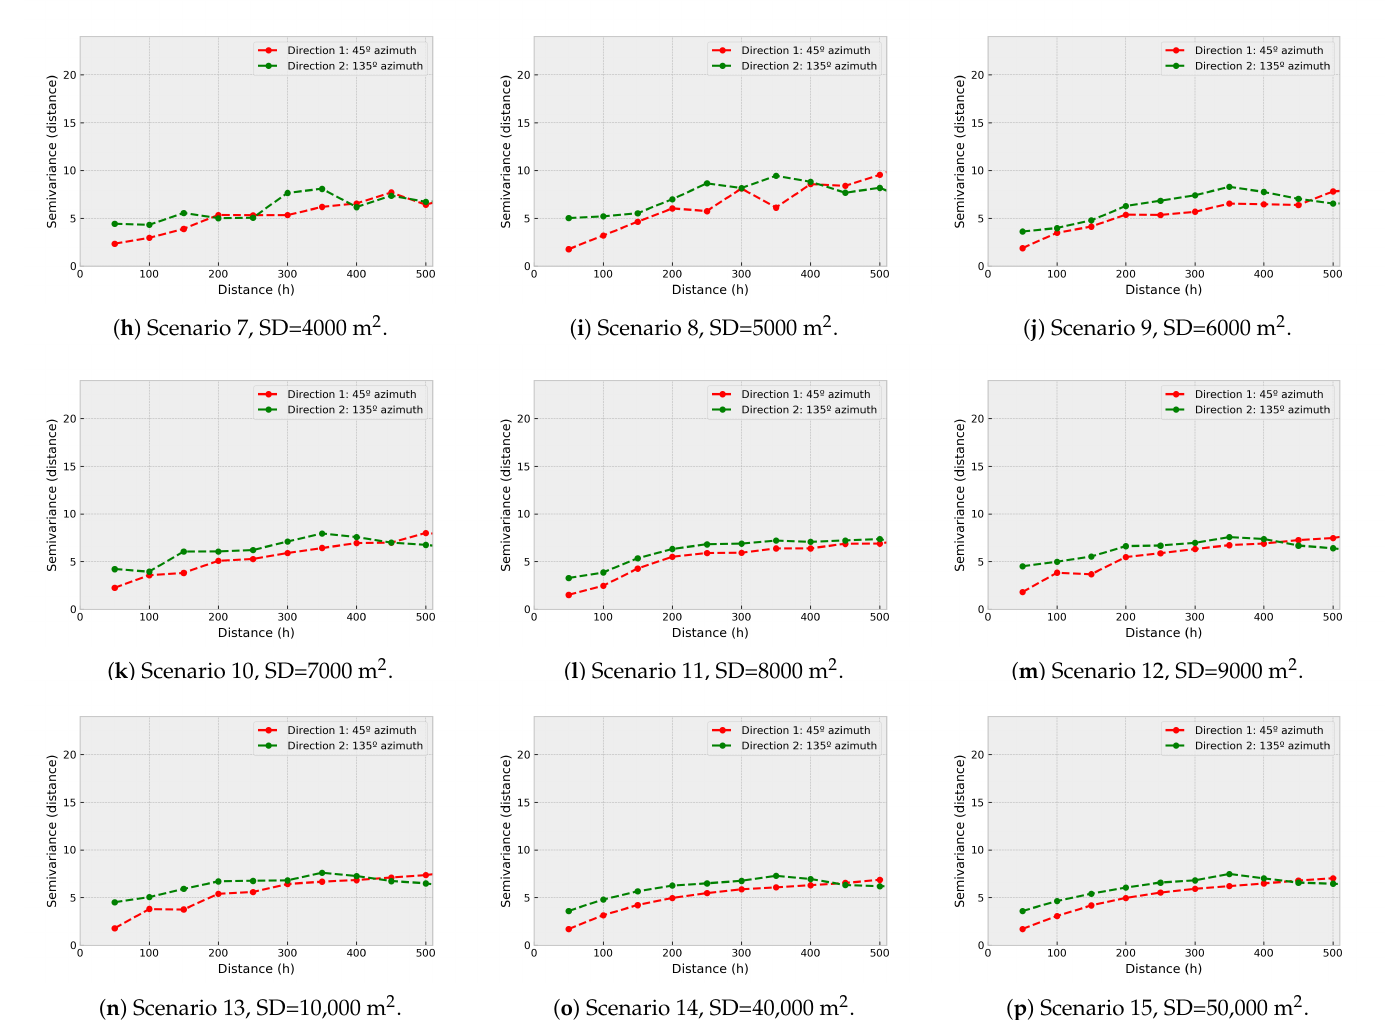
Figure 9. Coestimation direct semivariograms versus simulated real Z 1